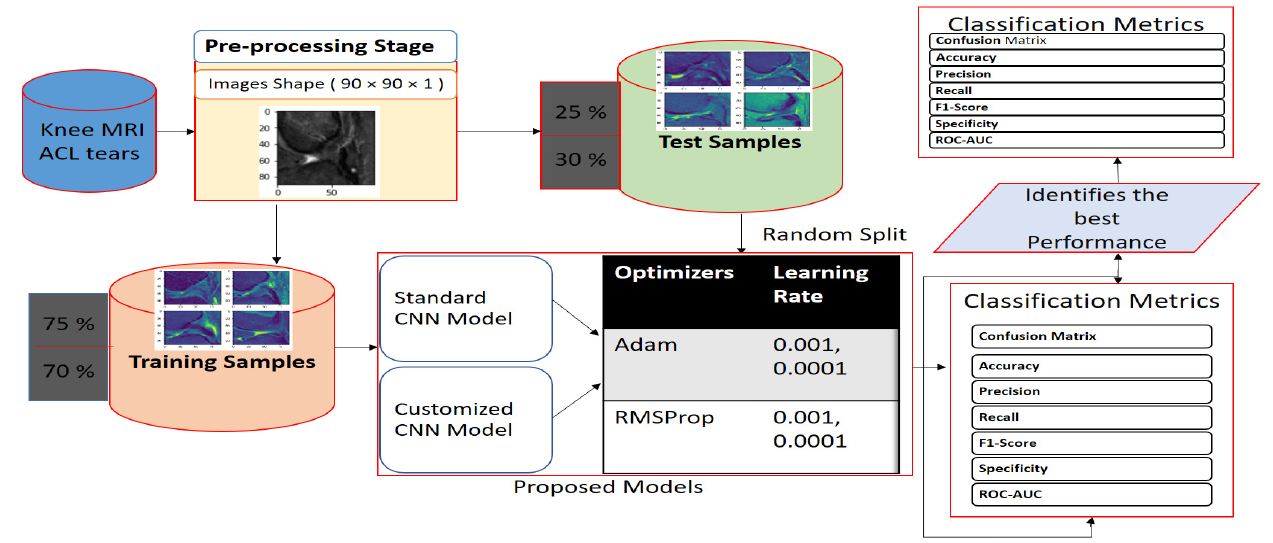
Figure 4. Graphical representation of the block architecture of our